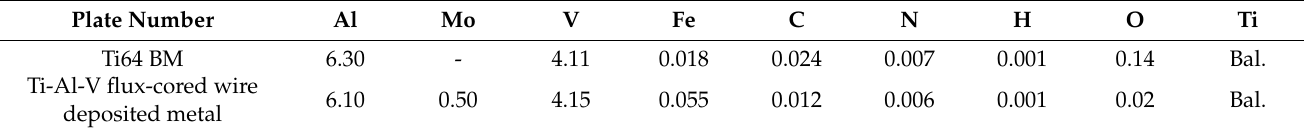
Table 1. Chemical composition of the BM and deposited metal (mass fraction, %).